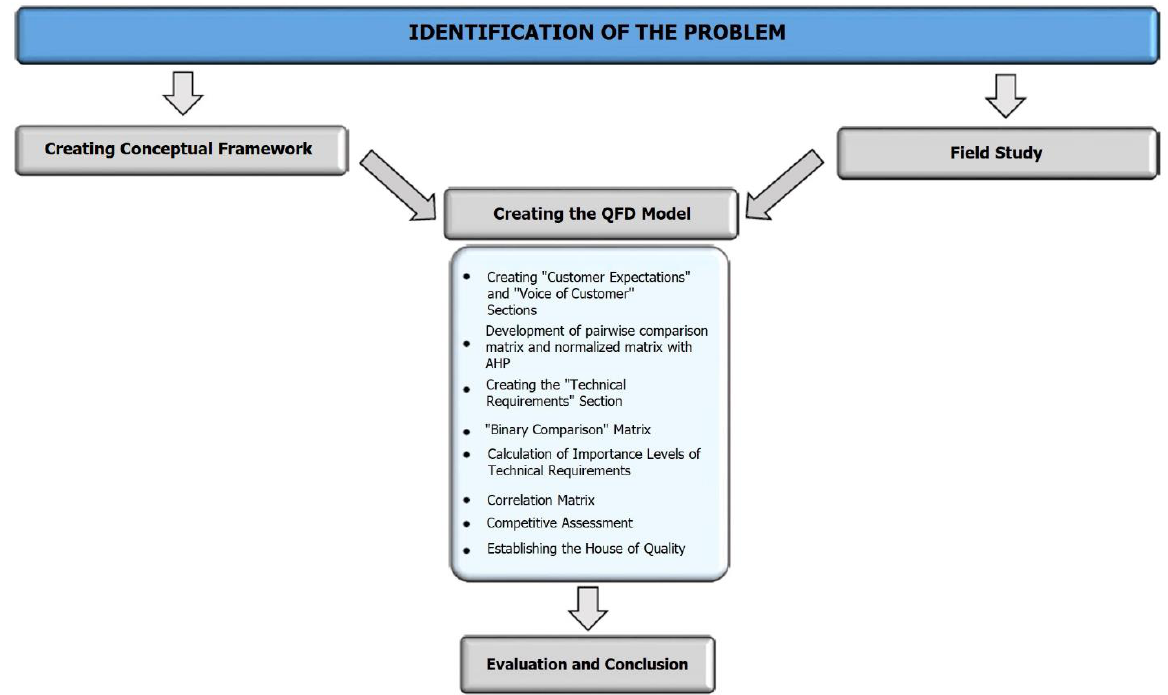
Figure 1. The structure of the study.